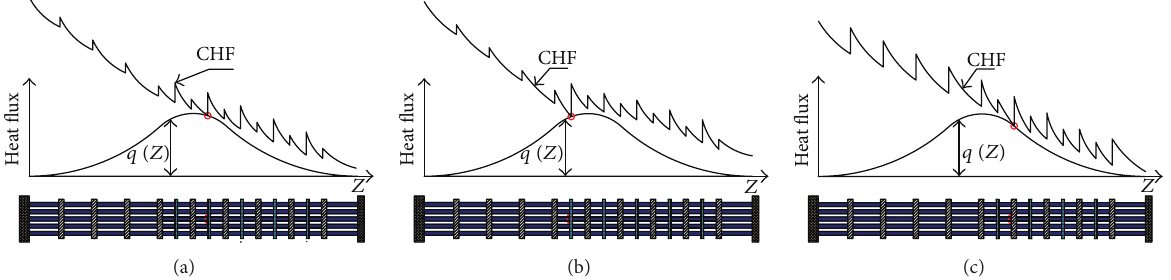
Figure 5: Actual burnout (CHF) location in a rod bundle with cosine APD can vary depending on the actual grid location, the grid span, and the gird alignment, as well as local operating conditions.